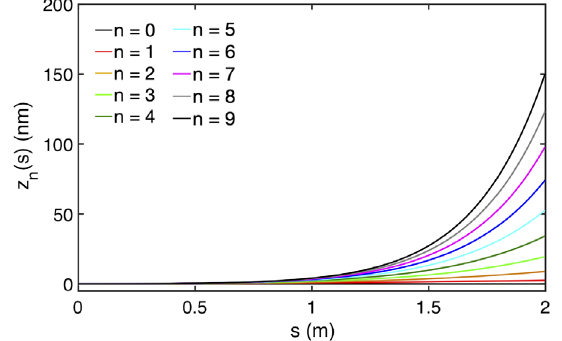
FIG. 7. Evolution of the longitudinal centroid offsets along s based on Eq. (21) with k s ¼ k s 0 , i.e., without potential-well term. The initial parameters are the same as those in Fig. 6.